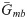
Shifts in cell electrical properties including membrane conductance, and cytoplasmic conductivity, and membrane capacitance are associated with the increasingly malignant phenotypes of the MOSE-E, MOSE-L, and MOSE-LTICν cells.When the single-shell model was fit to experimental data from for cell individually, the paired kernel density estimates (KDE) of A: cytoplasmic conductivity (σcp) and membrane conductance (G¯mb), B: cytoplasmic conductivity and membrane capacitance (C¯mb), and C: membrane conductance and membrane capacitance demonstrate shifts in the dielectric phenotype associated with increasingly malignancy. Error bars are centered at the mean for the cell type and represent the standard deviation. Calculated for each cell, the MOSE-E, σcp = 0.78±0.41 S/m, G¯mb=0.71±0.39 S/cm2, and C¯mb=0.051±0.017 F/m2. For MOSE-L, σcp = 1.01±0.33 S/m, G¯mb=1.37±0.62 S/cm2, and C¯mb=0.063±0.009 F/m2. For MOSE-LTICν, σcp = 1.31±0.45 S/m, G¯mb=1.62±0.55 S/cm2, and C¯mb=0.065±0.056 F/m2. The Levenberg-Marquardt algorithm was uses for fitting data from individual cells.